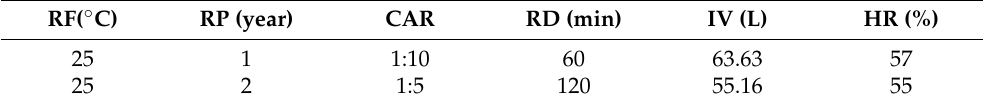
Table 6. The design rainfall parameters.